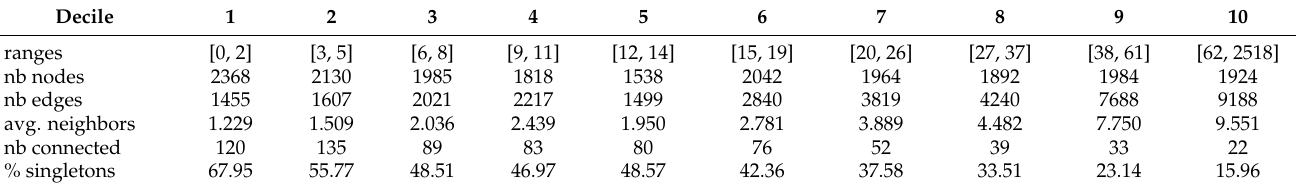
Table 2. Interaction data for human proteins depending on their rate of